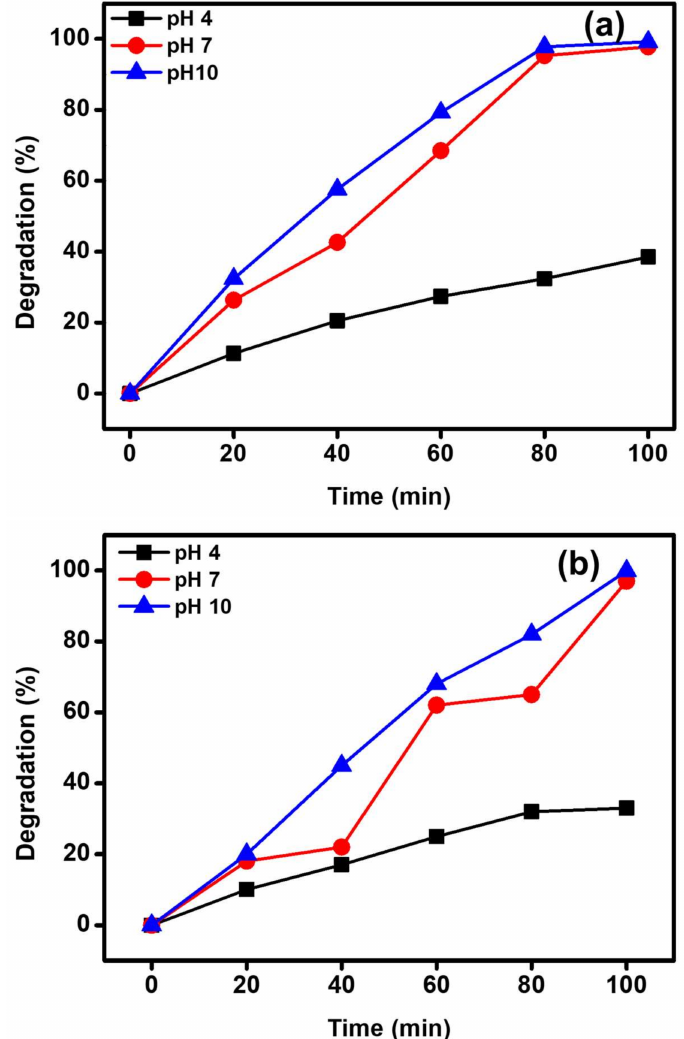
Figure 10. Impact of pH value on the catalytic performance of the ZnO photocatalyst on the ( a ) MB and ( b ) MY